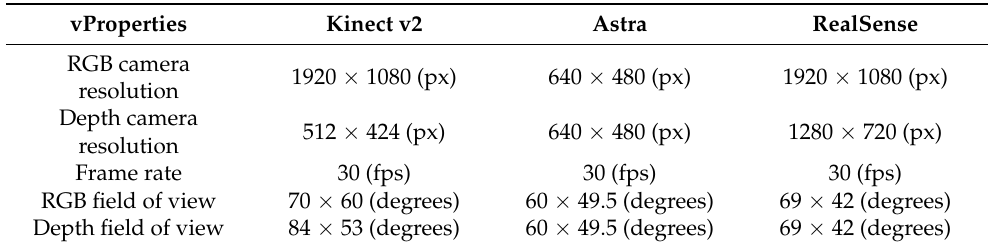
Table 2. Specification of the equipment